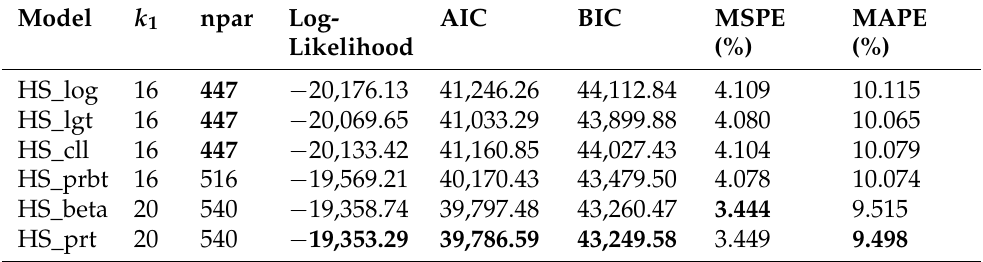
Table 6. Results of the quantitative tests for the Greek mortality